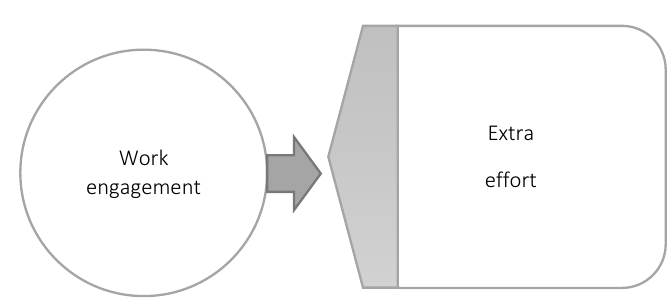
Figure 2. Parallel Framework